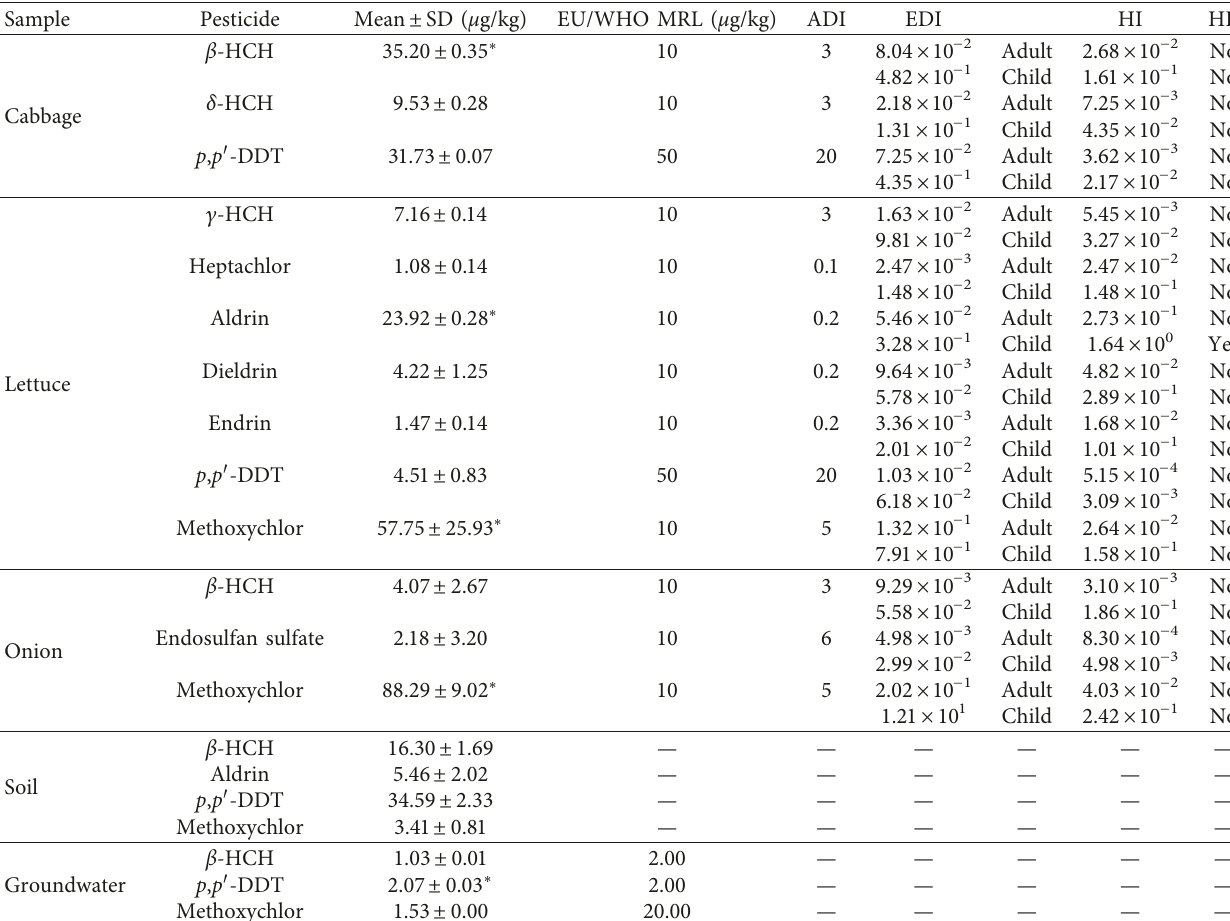
Table 5: Concentration, EDI, and health risk estimation for OCP residues detected in vegetables from Kentinkrono. Sample Pesticide